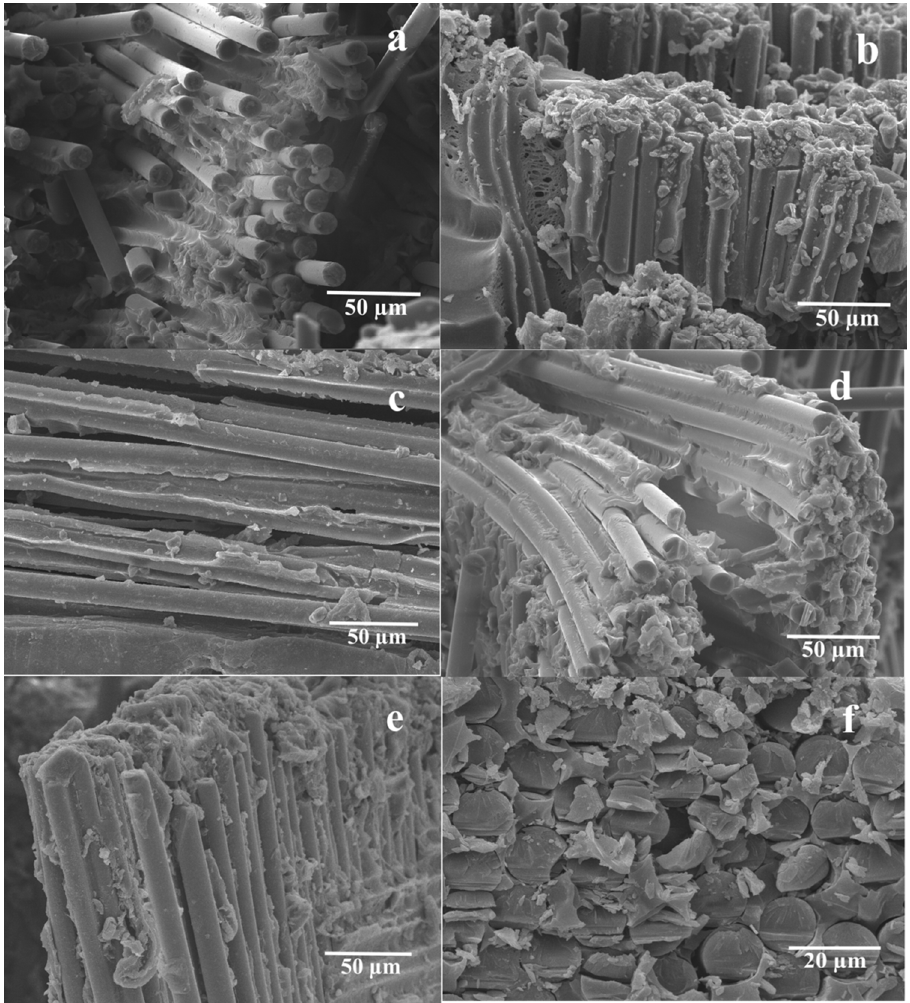
Figure 8. SEM images of the flexural fracture surfaces of the 50 / 50 ( a , b ), 60 / 40 ( c , d ), and 70 / 30 ( e , f ) PSU based composites reinforced with the initial ( a , c , e ) and the preheated ( b , d , f ) GF.